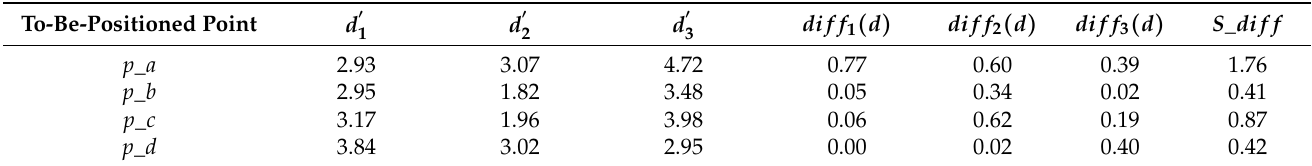
Table 8. The ranging results and errors of the adaptive calibration algorithm